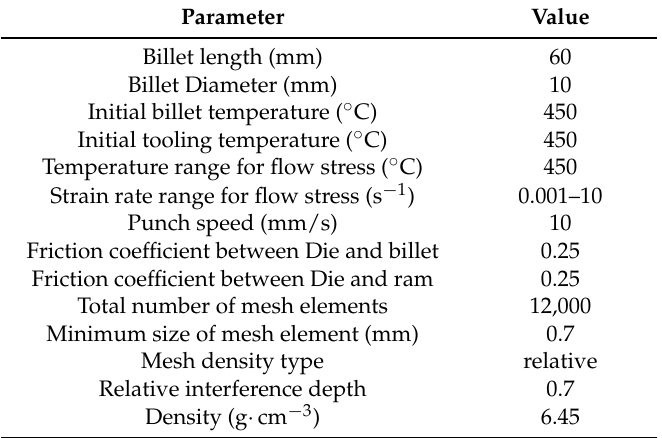
Table 1. Simulation parameters and physical properties of Ti 49.2 Ni 50.8